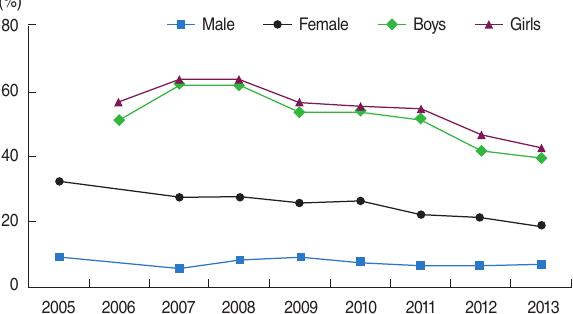
Figure 2. Trends in prevalence of secondhand smoke exposure at home 1,2 in the Korea National Health and Nutrition Examination Survey during 1998 to 2013, and Korea Youth Risk Behavior Web-based Survey during 2006 to 2013. Proportions of adults were calculated using the direct standardization method and was based on a 2005 population projection. 1 Adults (aged 19 years and older; age-standardized): percentage of current non-smokers who were exposed to cigarette smoke at home (2013: during the past 7 days). 2 Ad- olescents (aged 13-18 years): percentage of students who were expos ed to secondhand smoke at home on more than 1 day during the past 7 days.